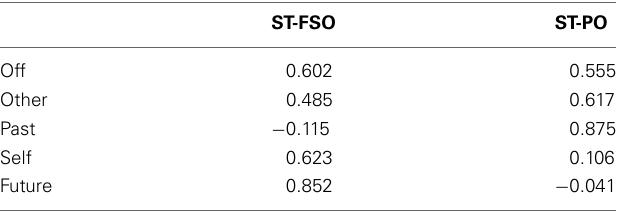
Table 1 | Component loadings obtained from the PCA with Varimax Rotation on the SGT